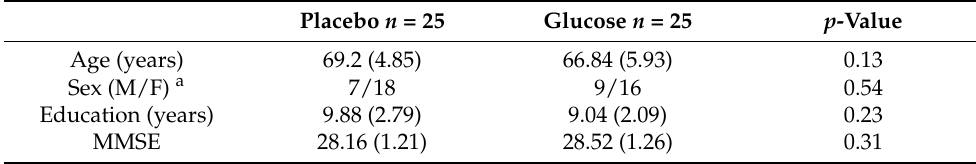
Table 3. Characteristics of the sample in two drink